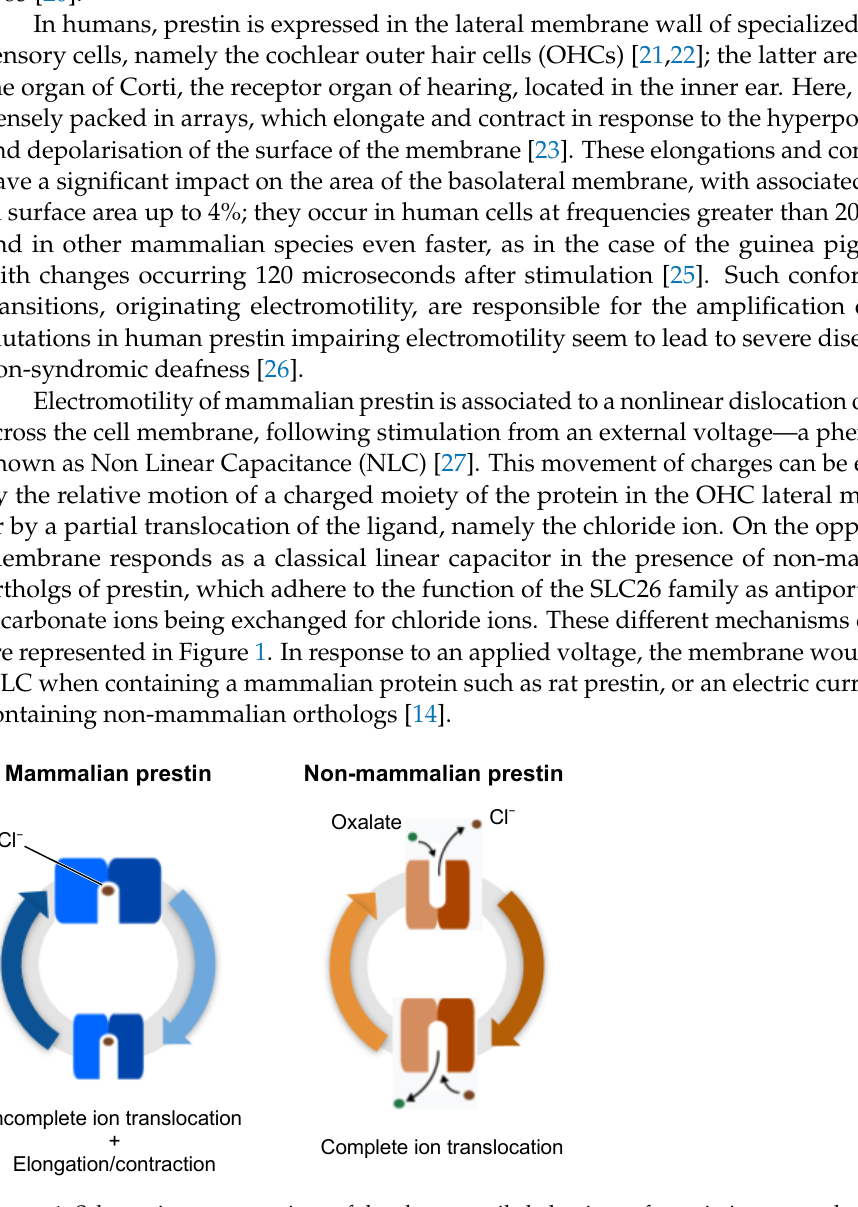
Figure 1. Schematic representations of the electromotile behaviour of prestin in mammals (blue), and of the full substrate transport process in non-mammalian prestin